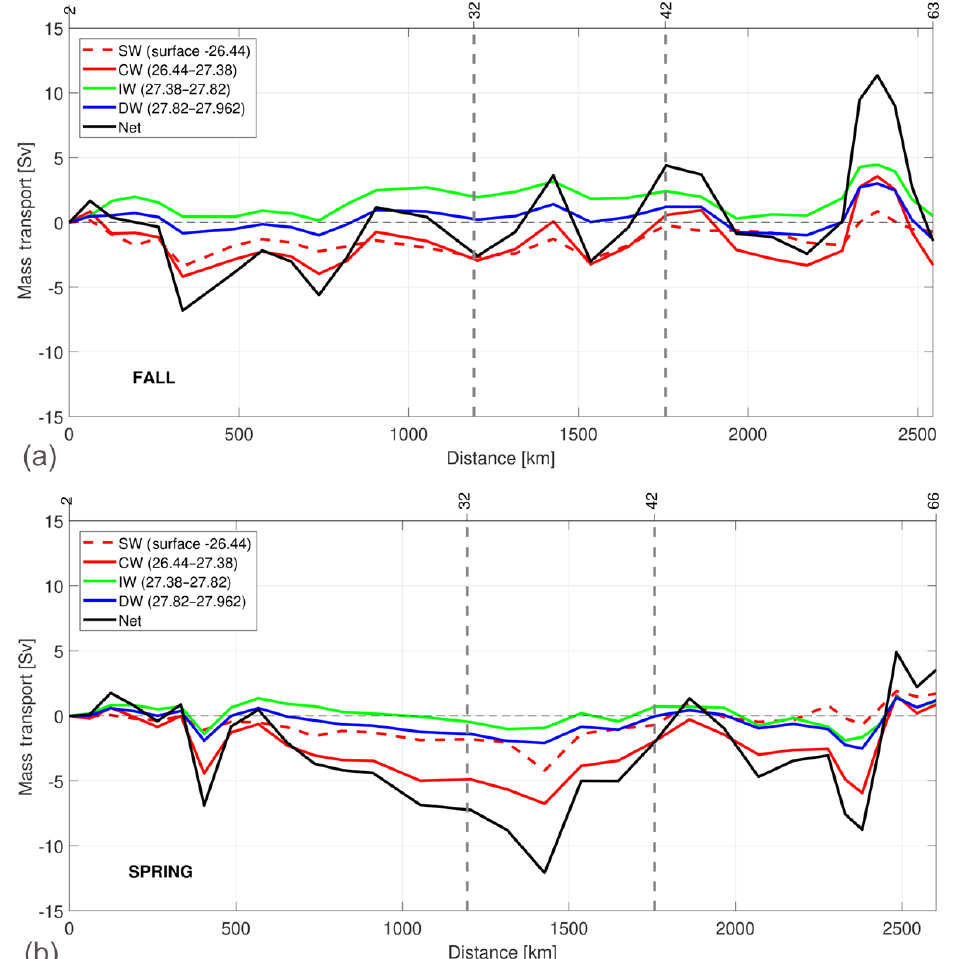
Figure 12. Accumulated mass transport along the fall (a) and spring (b) cruises at the surface waters (SW, in red and dashed line), central waters (CW, in red line), intermediate waters (IW, in green line) and deep waters (DW, in blue line). The accumulated mass transport integrated for all nine layers is also represented. The horizontal axis has the same direction as Fig. 2. Negative–positive values of transports along the three transects indicate inward–outward transports in the box delimited by the three transects and the African coast.